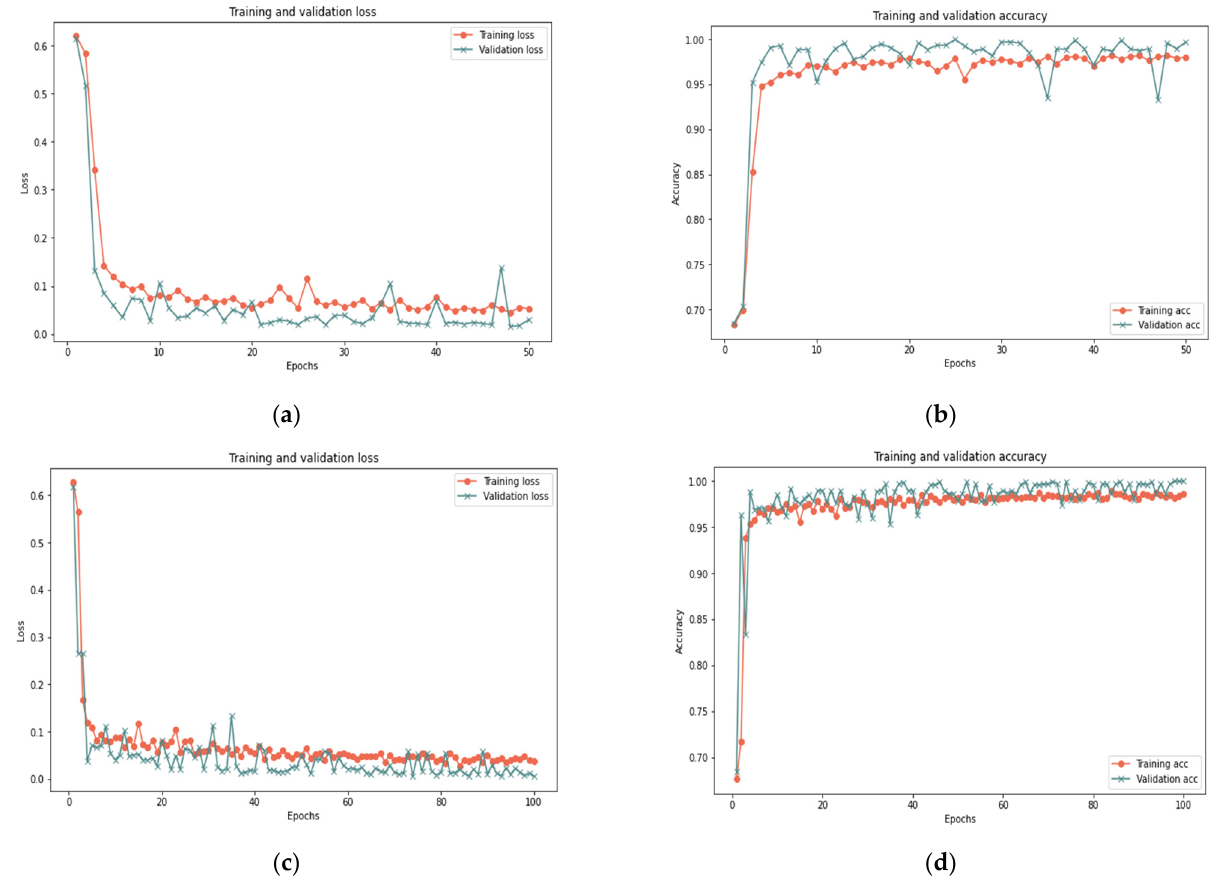
Figure 11. Results of the 100% sample size: ( a ) loss of 50 iterations, ( b ) accuracy of 50 iterations, ( c ) loss of 100 iterations, ( d ) accuracy of 100 iterations.